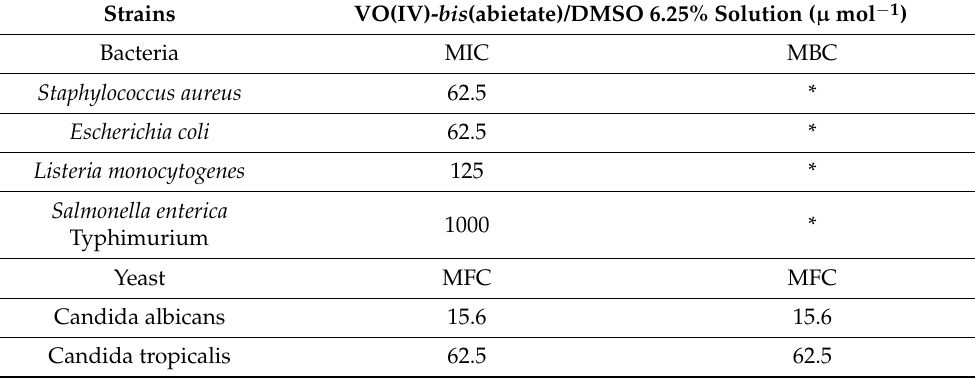
Table 3. Antibacterial and antifungal test (MIC/MBC/MFC) at various concentrations, in a solution of VO(IV)- bis (abietate) in DMSO (6.25%). Results in ( µ mol L − 1 ).